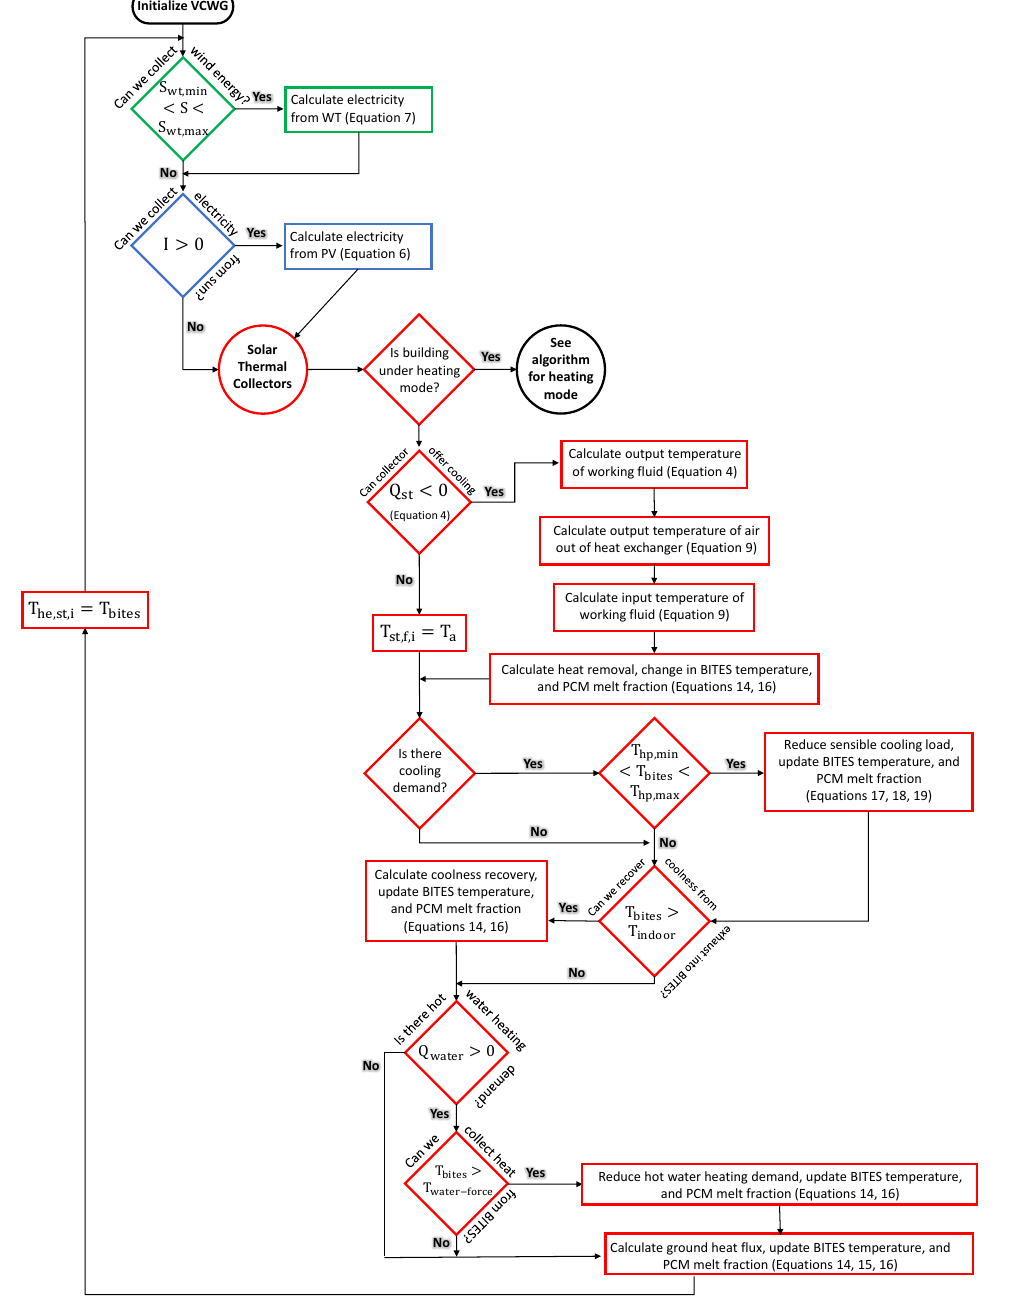
Figure 4. System control algorithm under cooling